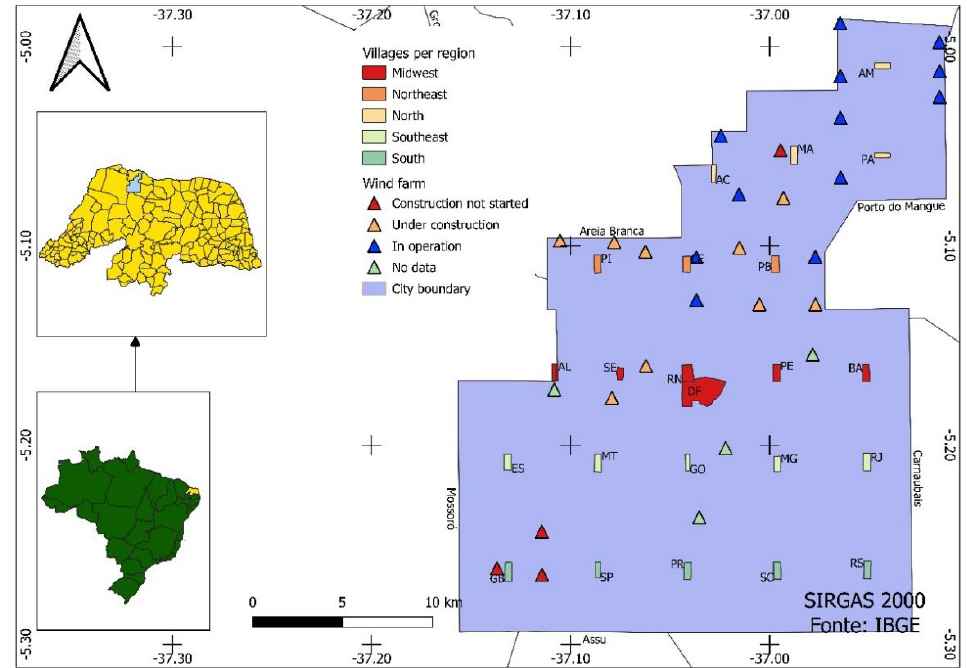
Figure 1. Map of location and division of towns and regions in the municipality of Serra do Mel. Lagend of the villages: Acre (AC), Alagoas (AL), Amazonas (AM), Bahia (BA), Brasília (DF, urban area), Ceará (CE), Espirito Santo (ES), Goiás (GO), Guanabara (GB), Maranhão (MA), Mato Grosso (MT), Minas Gerais (MG), Pará (PA), Paraíba (PB), Paraná (PR), Pernambuco (PE), Piauí (PI), Rio de Janeiro (RJ), Rio Grande do Norte (RN), Rio Grande do Sul (RS), São Paulo (SP), Santa Catarina (SC) and Sergipe (SE).